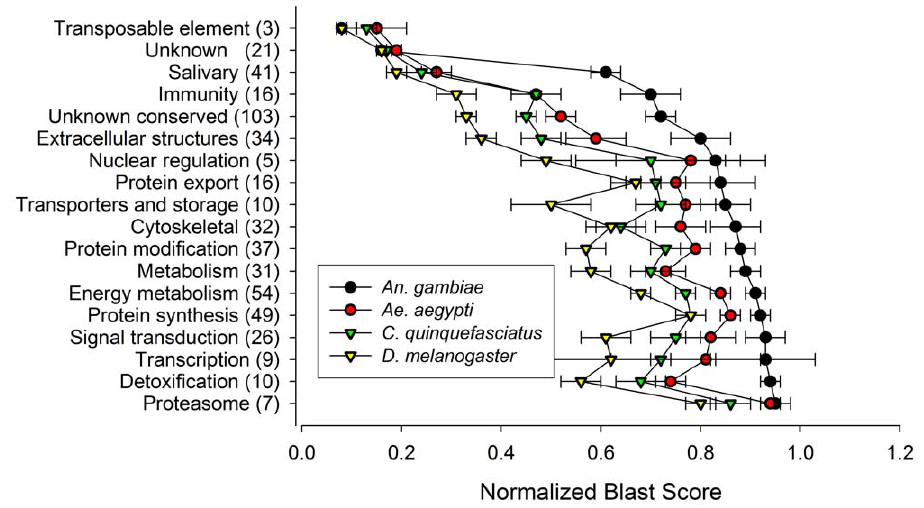
Figure 3. Average normalized BLAST scores ( 6 SE) for protein comparisons between An.funestus and four other species. Black circle, An. gambiae ; red circle, Ae. aegypti ; green triangle, Cx. quinquefasciatus ; yellow triangle, D. melanogaster ). Corresponding functional categories (and number of protein comparisons in each) are indicated at left.